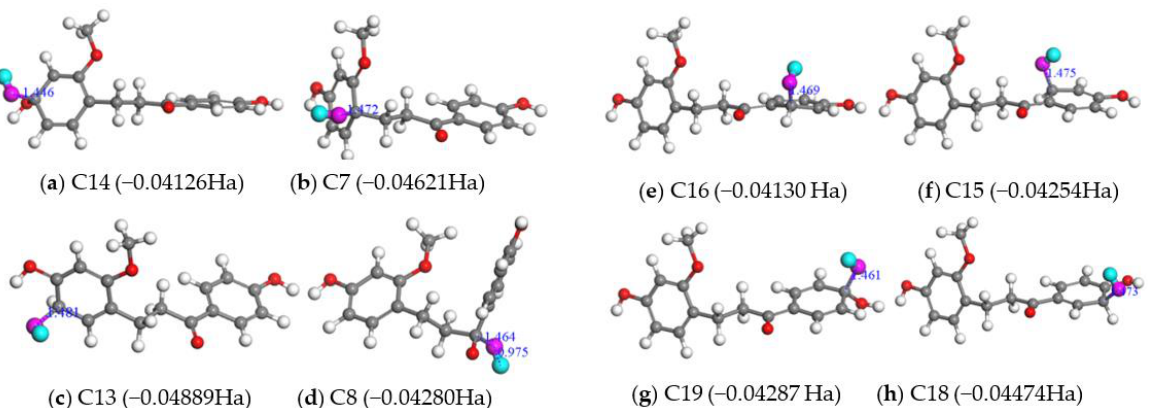
Figure 6. Optimized structures of the radical adducts of LC+OH • in gas phase. OH • was added on the C14 ( a ), C7 ( b ), C13 ( c ) sites of LC (A ring, left); on the site of H8 of the C=O double bond ( d ); on the C16 ( e ), C15 ( f ), C19 ( g ), C18 ( h ) sites of LC (B ring, right). The energy difference between the